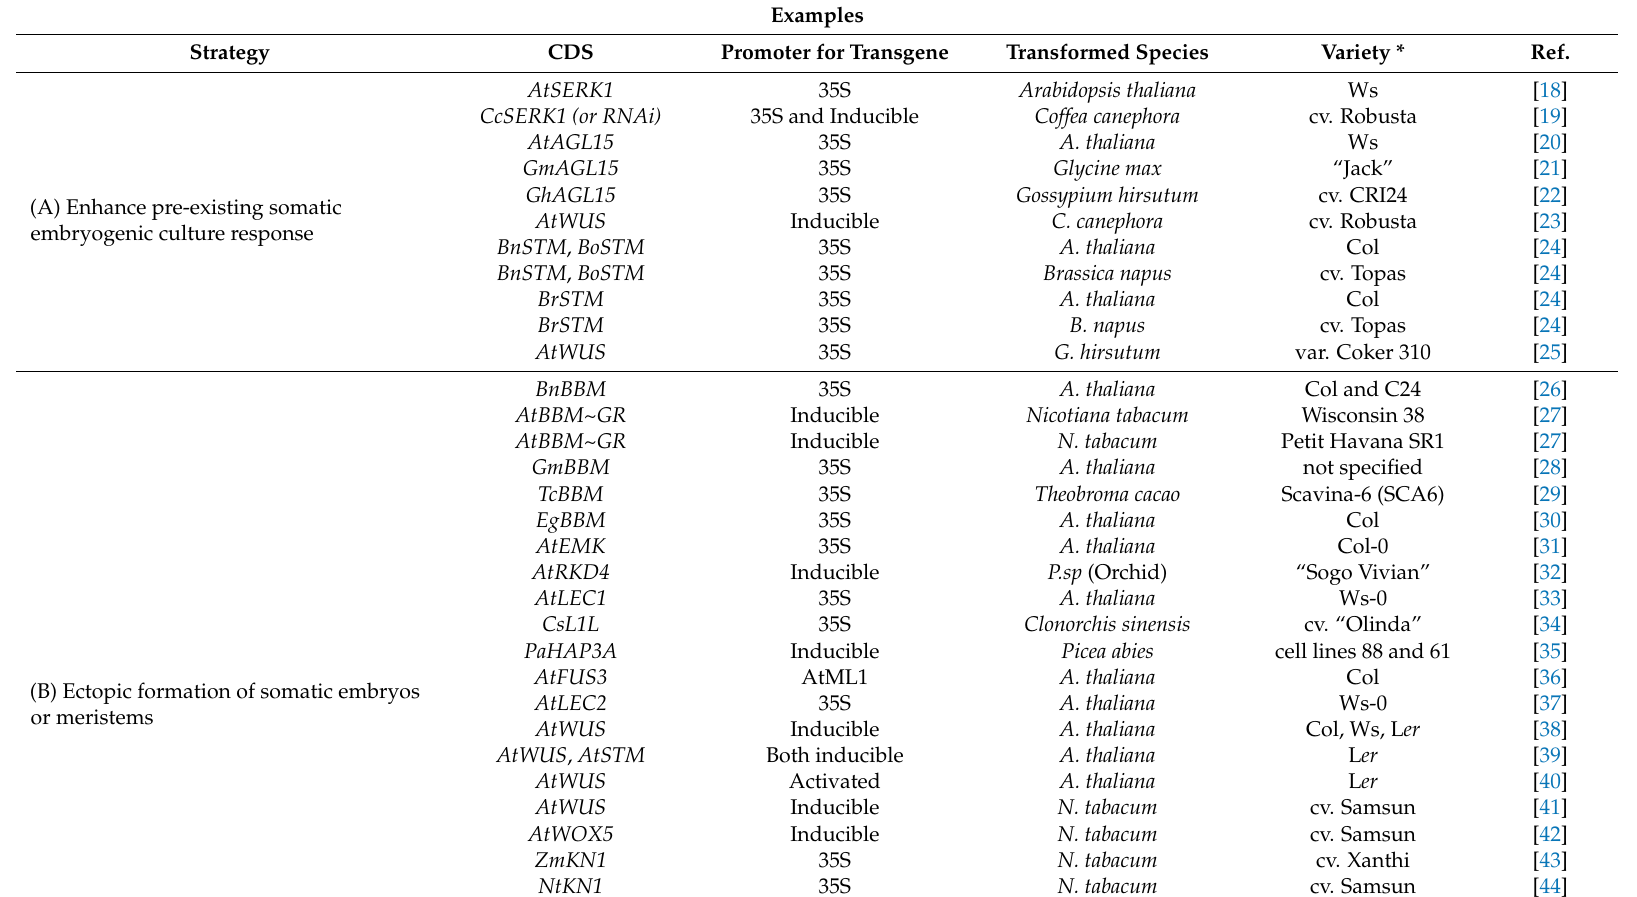
Table 1. Strategies to improve transformation using morphogenic